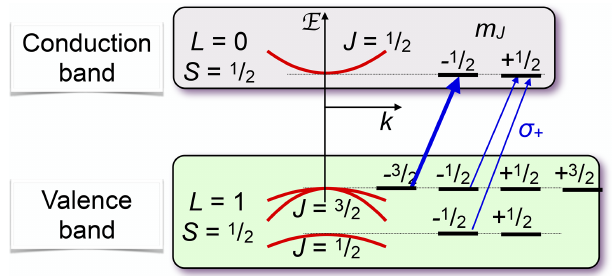
Figure 20. Optical pumping in a direct-band-gap semiconductor. The arrows mark the allowed optical transitions for circularly po- larized